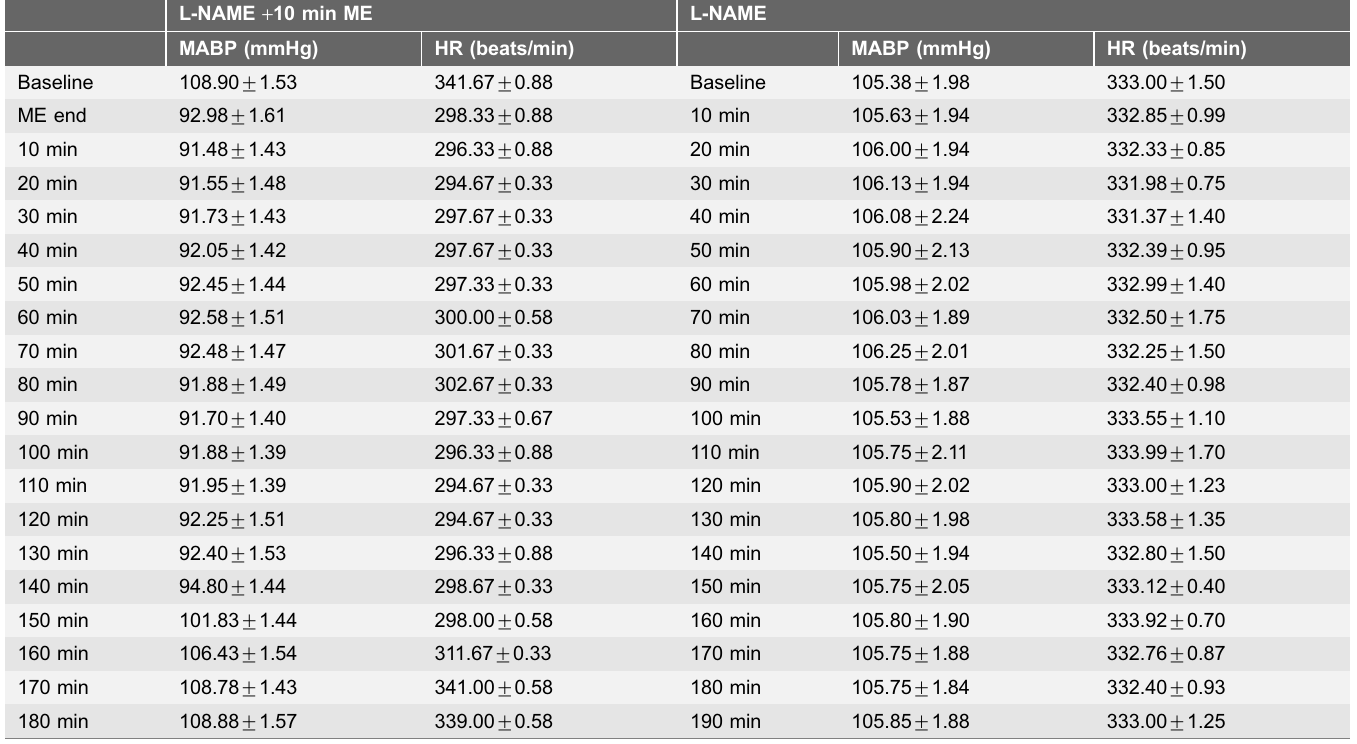
Table 3. Effects of local administration of L-NAME on MABP and